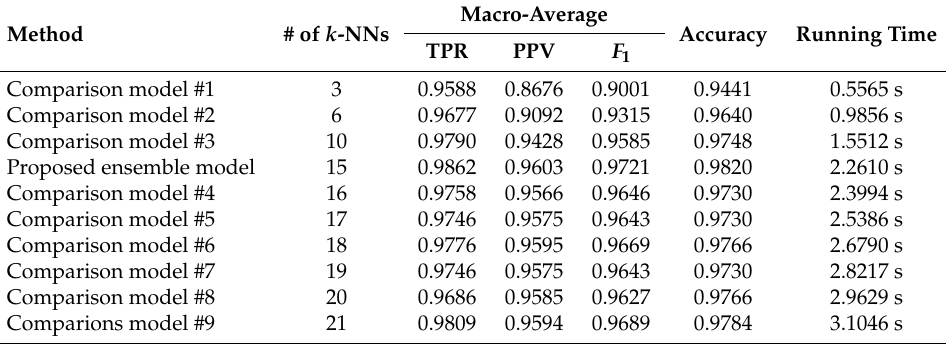
Table 2. Five-fold cross-validation performance comparisons between ensemble models with different